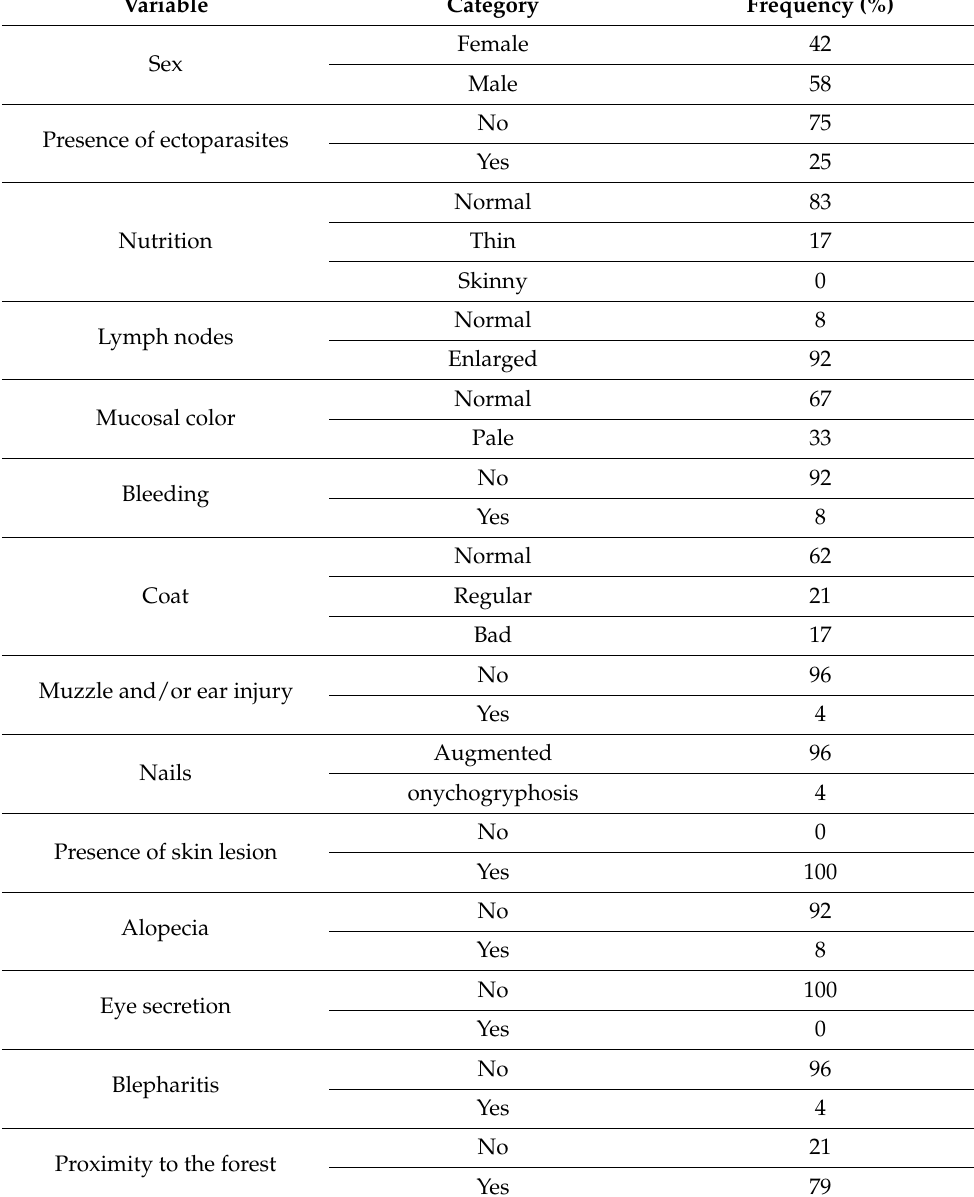
Table 7. Frequency of the variables for the true negatives samples.